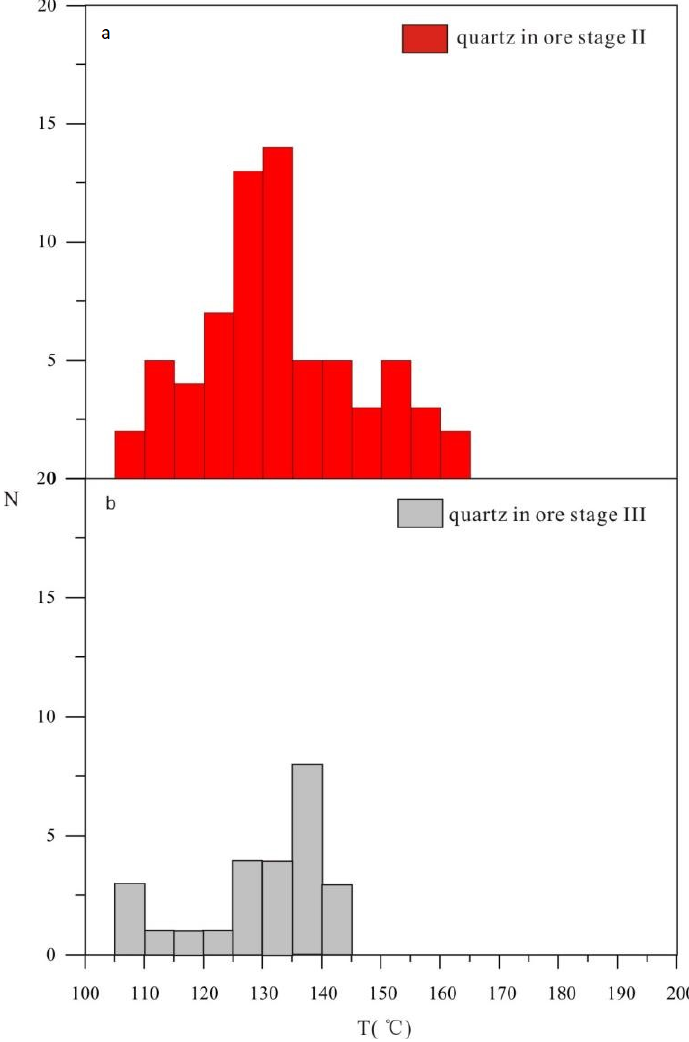
Figure 6. Histograms of homogenization temperatures of fluid inclusions of the Dongpuzi gold de- posit. (( a ): homogenization temperatures of fluid inclusions from the ore stage II; ( b ): homogenization temperatures of fluid inclusions from the ore stage III).